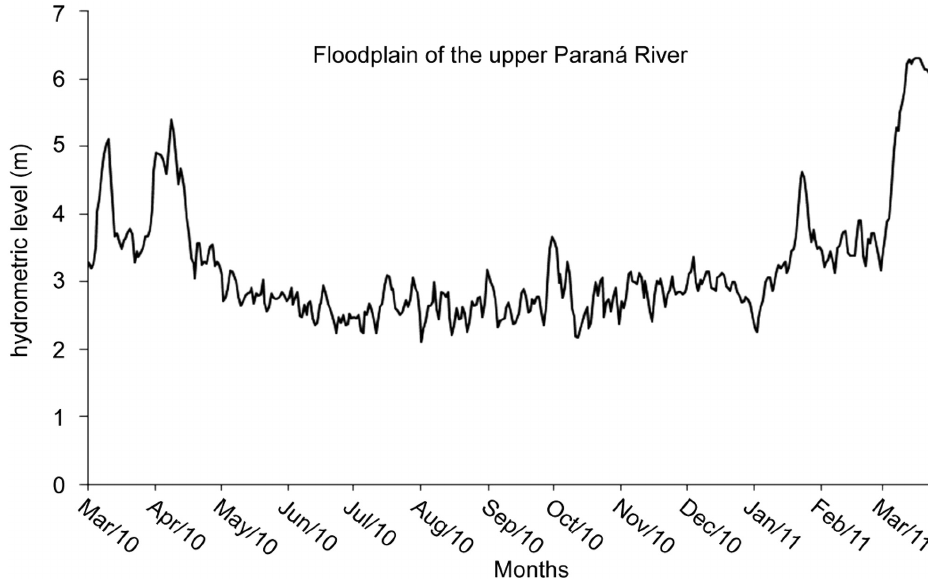
Fig. 2. Hydrometric level from dry and wet periods in the floodplain of the Upper Paraná